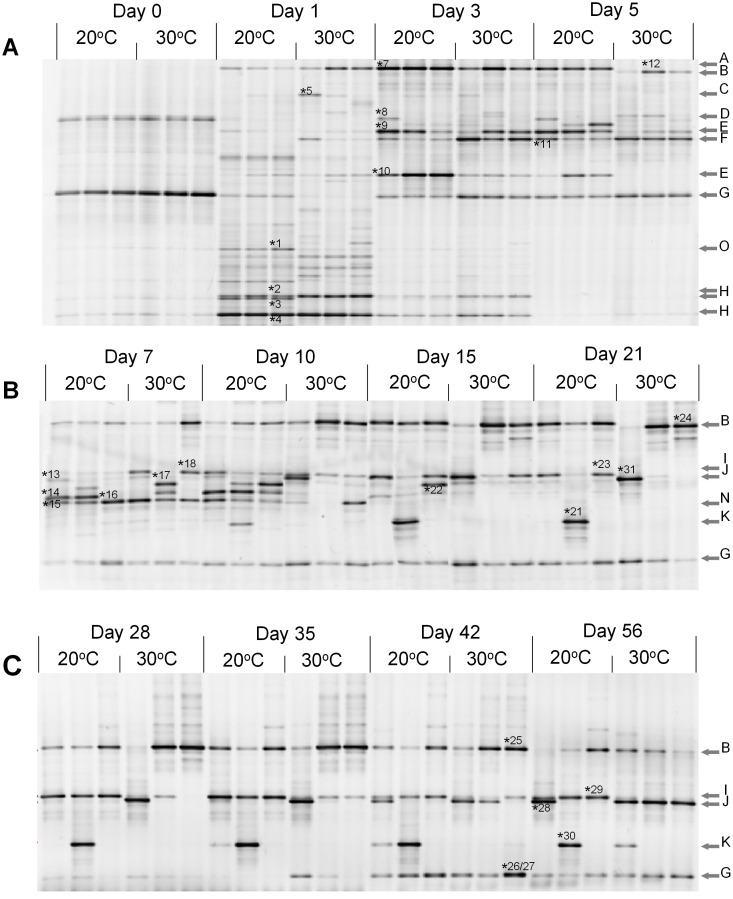
DGGE analysis of six rye sourdoughs propagated at 20°C (20-I, 20-II and 20-III) and 30°C (30-I, 30-II and 30-III) during 56 days.The arrows indicate specific bands for the following groups: (A) Weissella sp., (B) Lactobacillus plantarum, (C) Enterobacteriaceae, (D) Lactobacillus sp., (E) Lactobacillus sp., (F) Pediococcus sp., (G) Cereal chloroplast, (H) Pantoea agglomerans, (I) Lactobacillus brevis, (J) Lactobacillus paralimentarius, (K) Lactobacillus crustorum, (M) Lactobacillus curvatus/graminis/sakei, (N) Pediococcus pentosaceus, (O) Gamma Proteobacteria species. The bands marked by numbers were cut and sequenced. The closest matches are shown in the Table 2. A. DNA samples from days 0, 1, 3 and 5 of backslopping. B. DNA samples from days 7, 10, 15 and 21 of backslopping. C. DNA samples from days 28, 35, 42 and 56 of backslopping.